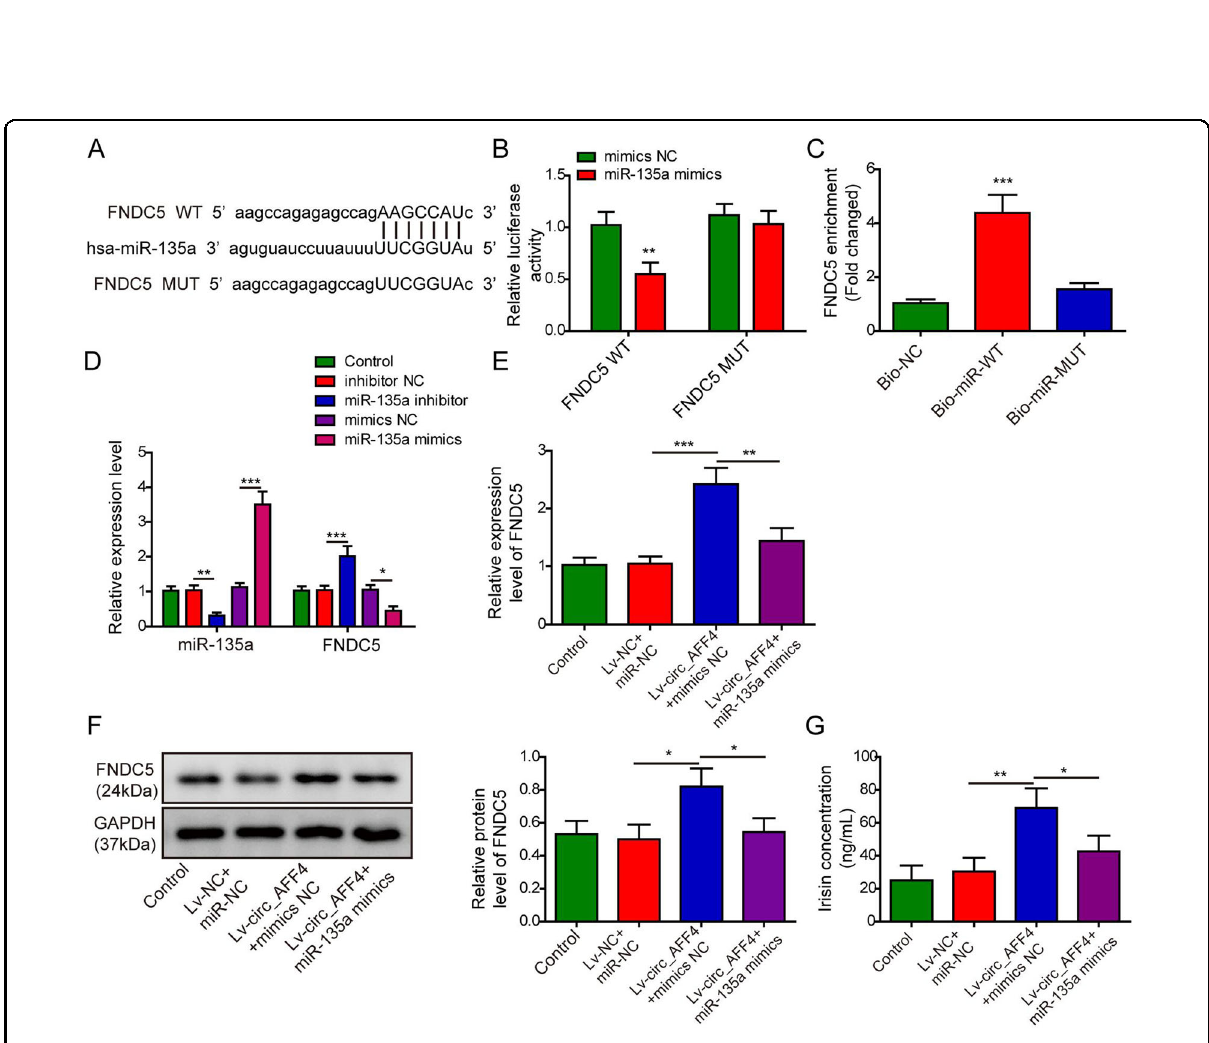
Fig. 4 circ_AFF4 enhanced expression of FNDC5/Irisin through targeted binding with miR-135a-5p. A Potential binding sites between FNDC5 and miR-135a-5p were predicted by using the RNAInter web tool. The complementary binding between FNDC5 and miR-135a-5p was validated by dual-luciferase reporter ( B ) and RNA pull-down assays ( C ). D BM-MSCs were transfected with lentiviruses expressing miR-135a-5p mimics, miR-135a- 5p inhibitor, or negative control. Relative expression of miR-135a-5p and FNDC5 was determined using qRT-PCR. E BM-MSCs were co-transfected with lentiviruses encoding circ_AFF4 and miR-135a-5p mimics or miRNA negative control. Molecular expression of FNDC5 at mRNA and protein levels was analyzed by qRT-PCR ( E ) and western blot ( F ) analysis respectively. G Irisin expression in BM-MSCs was quanti fi ed by ELISA using an anti- Irisin antibody. The data were shown as mean ± SD based on at least three independent experiments. * P < 0.05, ** P < 0.01, and *** P <